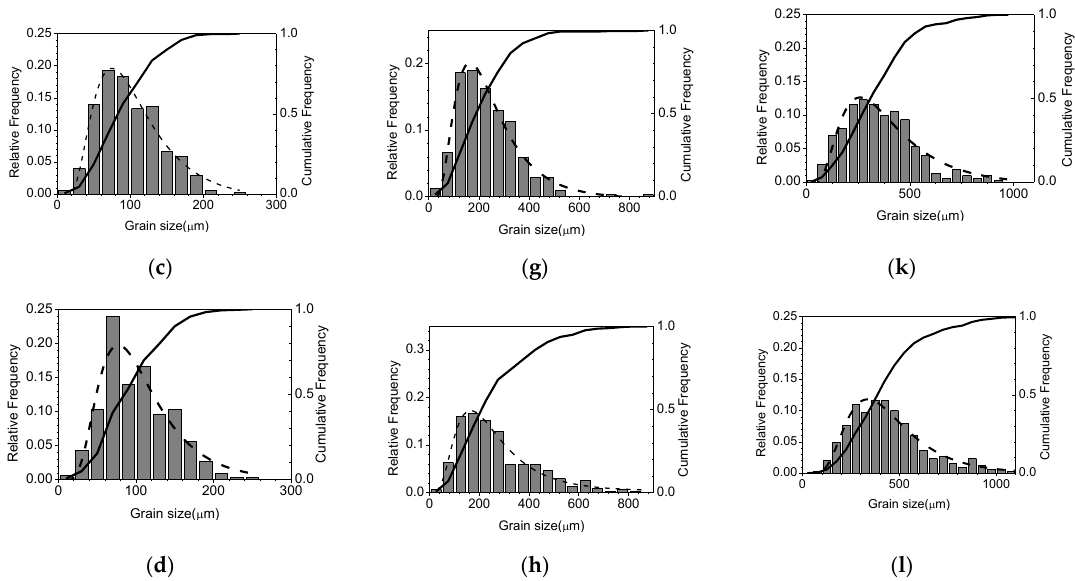
Figure 3. Histogram and cumulative frequency distributions of grain size of austenite in SS400 steel with 1.5 ppm Mg for ( a, e, i ) 3 min, ( b, f, j ) 5 min, ( c, g, k ) 10 min, and ( d, h, l ) 20 min. Broken lines represent the curves fitted by the log-normal function: ( a – d ) at 1150 °C, ( e – h ) at 1200 °C, and ( i – l ) at 1250 °C.